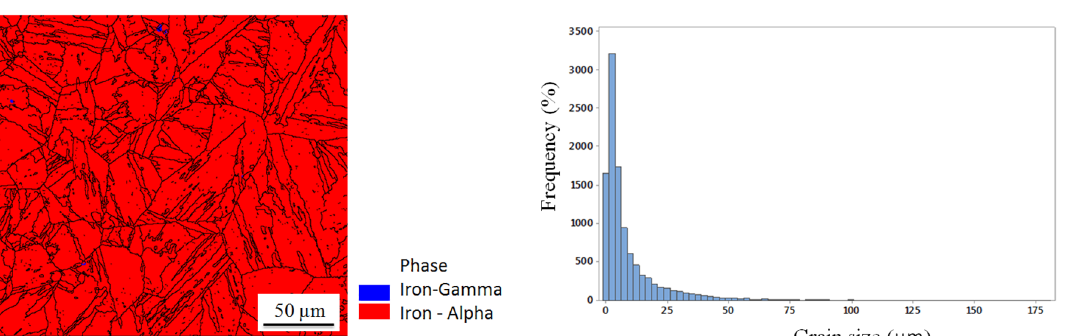
Figure 6. Orientation image maps for the supermartensitic steel samples after tempering for 30 min at a temperature range of 600-640°C.